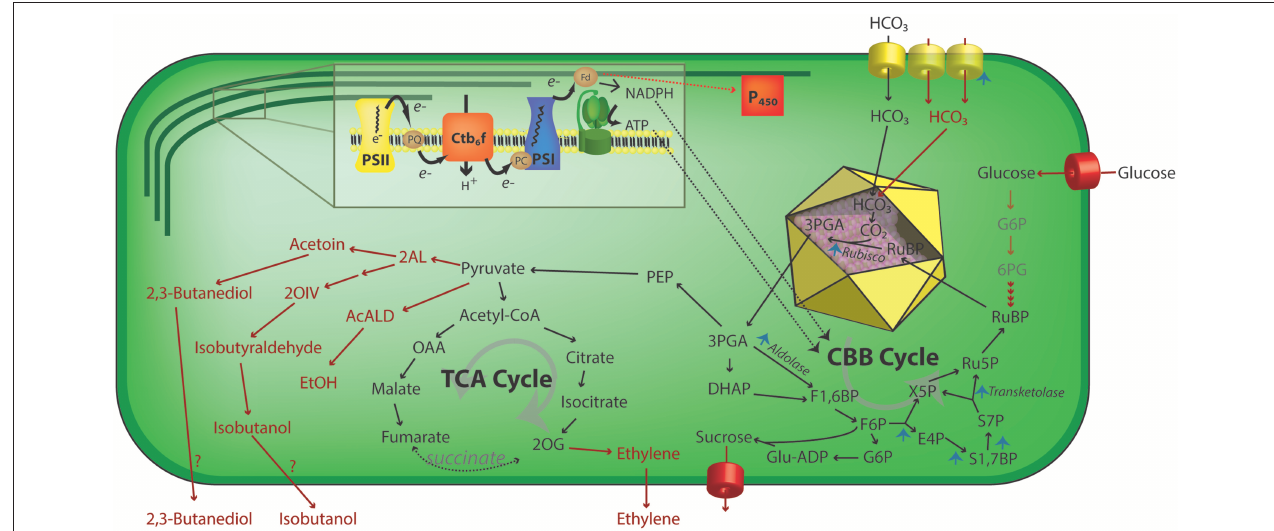
FIGURE 3 | Schematic representation of engineering strategies that increase photosynthetic activity in cyanobacteria. Using ATP and NADPH produced by the light reactions (inset), the CBB acts to assimilate inorganic carbon via a RuBisCO—mediated reaction in the carboxysome (yellow icosahedron) lumen. Upregulation of multiple steps of the carbon concentration mechanism or CBB cycle enzymes has been shown to increase total carbon uptake rates by cyanobacteria (blue arrowheads). Additionally, the regeneration of RuBisCO substrate, ribulose 1,5-bisphosphate, by feeding external carbohydrates has been used to increase CO 2 assimilation rates. Multiple metabolic pathways (red arrows) that have been heterologously expressed in cyanobacteria have also been demonstrated to increase the effective rate of carbon fixation, perhaps by relieving sink inhibition of photosynthesis. 2AL, 2-acetolactate; 2 OIV, 2-ketoisovalerate; 2OG, 2-oxoglutarate; 3PGA, 3-phosphoglycerate; 6PG, 6-phosphoglycerate; AcALD, acetaldehyde; Ctb 6 f, cytochrome b 6 f; E4P, erythrose 4-phosphate; EtOH, ethanol; F1,6BP, fructose-1,6-bisphosphate; F6P, fructose-6-phosphate; Fd, ferredoxin; G6P, glucose 6-phosphate; Glu-ADP, Glucose-ADP; OAA, oxalacetate; P450, cytochrome P450; PC, plastocyanin; PEP, phosphoenolpyruvate; PQ, plastoquinone pool; PSI, photosystem I; PSII, photosystem II; Ru5P, ribulose-5-phosphate; S1,7BP, sedoheptulose-1,7-bisphosphate; S7P, sedoheptulose-7-phosphate; TCA, tricarboxylic acid; X5P,